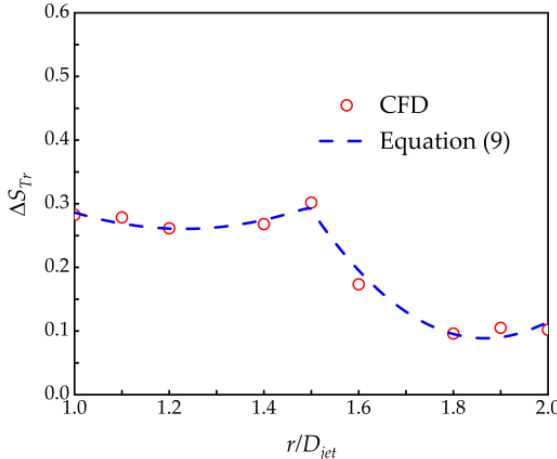
Figure 9. Change of speedup ratio with radial position ( Z/h = 0.0133).